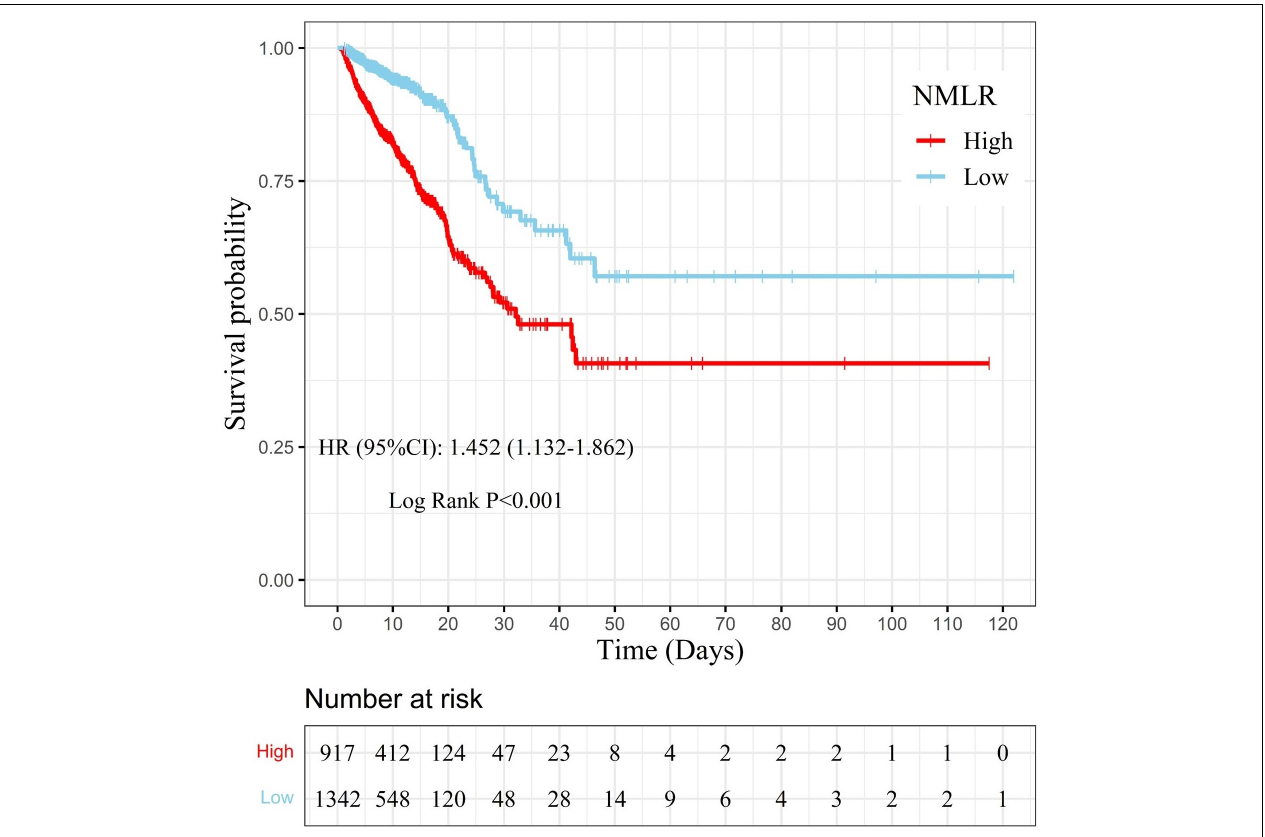
FIGURE 4 | Kaplan–Meier curve for samples with different admission NMLR levels. The survival probability of samples in the high admission NMLR group (NMLR ≥ 8.518) is indicated by the solid red line, whereas that of samples in the low admission NMLR group (NMLR < 8.518) is indicated by the solid blue line. Censors are indicated by “+”. The survival curve in the high admission NMLR group was significantly lower than that in the low admission NMLR group (log-rank test: P < 0.001). After adjusting for cofounders with a P -value < 0.05 in multivariate analysis, the Cox regression analysis showed that the high admission NMLR group was associated with an increased risk of in-hospital mortality compared to the low admission NMLR group (HR, 1.452; 95%CI, 1.132–1.862; P = 0.003). NMLR, (neutrophil+monocyte)/lymphocyte ratio; HR, hazard ratio; CI, confidence